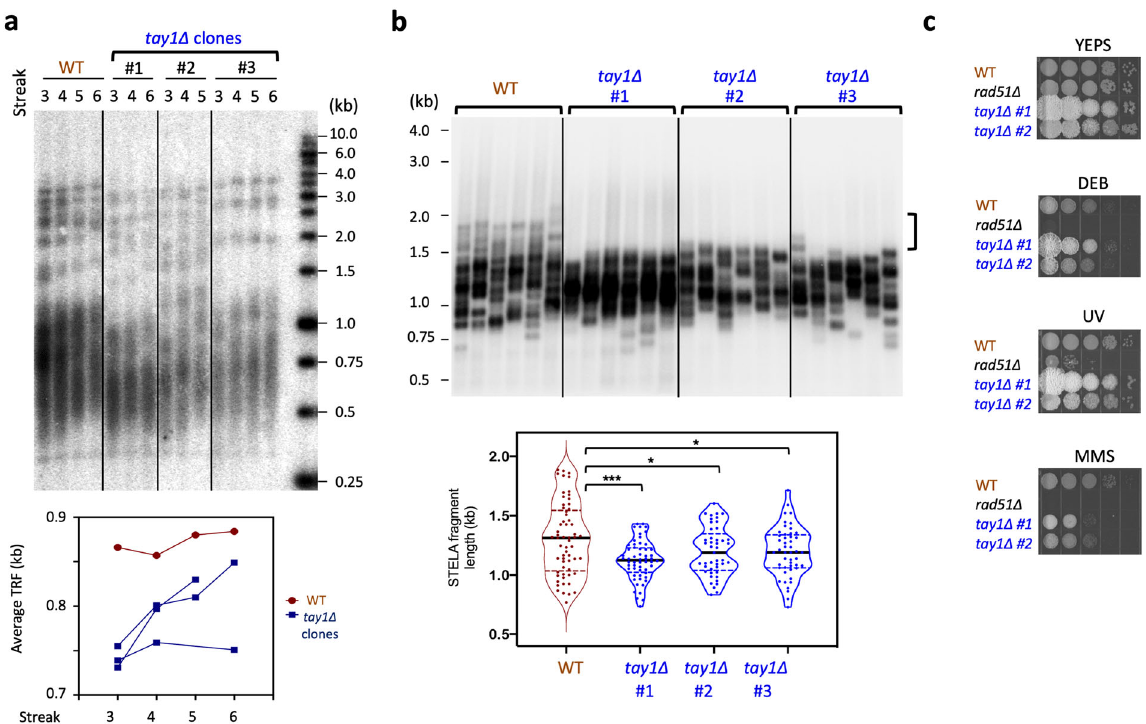
Fig. 3 Ustilago maydis Tay1 is required for optimal telomere replication, and plays a minor role in DNA damage response. a Chromosomal DNAs were prepared from wild type and three independent tay1 Δ transformants following the indicated number of streaks. Following Pst I cleavage, the DNAs were subjected to TRF Southern analysis. The phosphor scan of the blot is shown along with the plot of average telomere length for each sample. b Chromosomal DNAs from wild type and tay1 Δ strains were subjected to STELA. Following ligation to the Teltail oligonucleotide, UT4/5-containing telomeres were ampli fi ed using a UT4/5-speci fi c primer, and detected using a UT4/5 probe. Representative assays are shown on the top, with the vertical bracket to the right highlighting the long telomere fragments missing from the tay1 Δ samples. The composite STELA pro fi les (collected from n = 6 independent STELA PCR reactions) are displayed as violin plots (with means and quartiles) on the bottom. c Ten-fold serial dilutions of the indicated strains were spotted on YPD containing the indicated clastogens (0.02% MMS Methyl methanesulfonate; 0.01% DEB, 1,2,3,4-diepoxybutane) or subjected to UV irradiation (120 J/m 2 ), and their growth assessed after 2 – 3